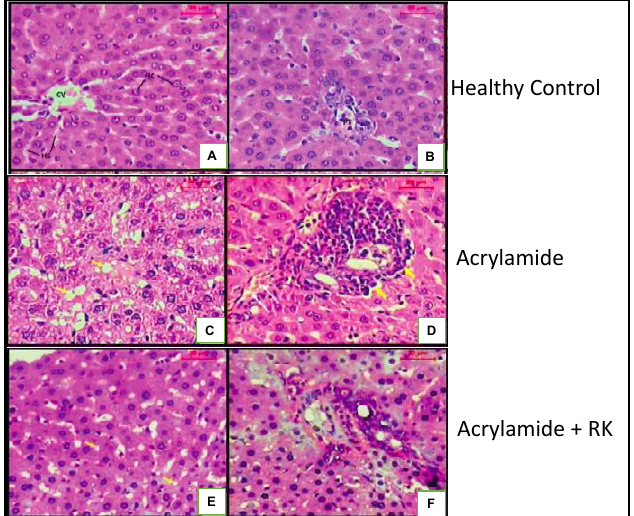
Figure 1. RK-mediated hepatic protection in rats after acrylamide-induced hepatic disease. A micrograph of a liver section of a healthy control ( A , B ), showing the normal architecture of a hepatic lobule. The central vein is surrounded by hepatocytes, hepatic sinusoids, and the normal portal tract. ( C , D ) The liver sections of the acrylamide-treated group showing the disturbance of the hepatic lobules, vacuoles in the hepatocytes, massive lymphocyte infiltration in the portal, and periportal spaces with dilated and congested veins. ( E , F ) The RK-acrylamide-treated group showing the hepatic lobule that appeared more or less like normal; the portal tract associated with mild infiltration and hepatocytes appeared almost normal. H&E staining; scale bar: 20 mm. Adapted from [24].